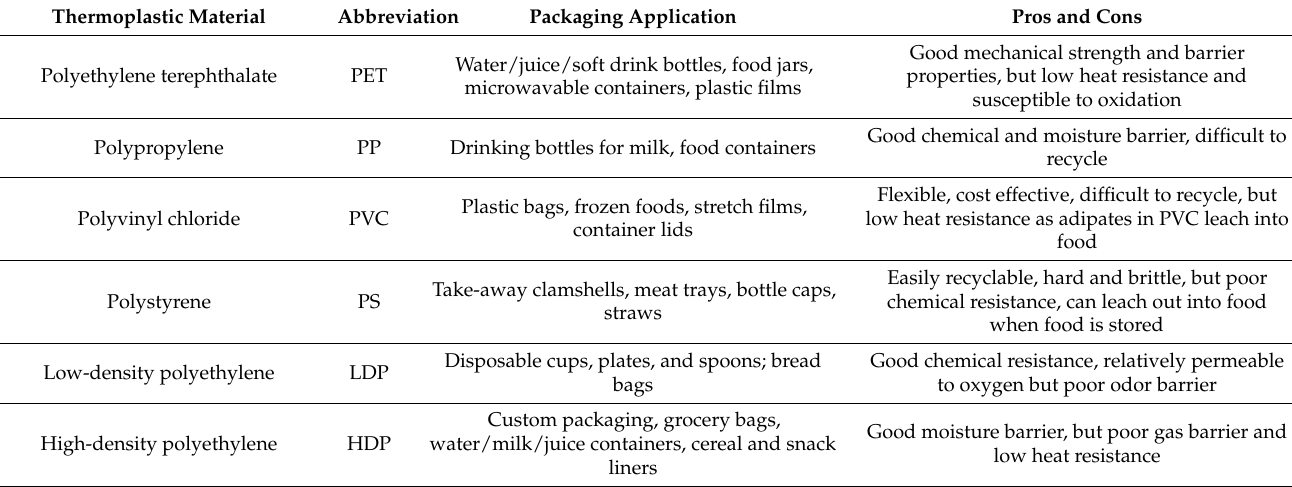
Table 1. Food packaging application from thermoplastics